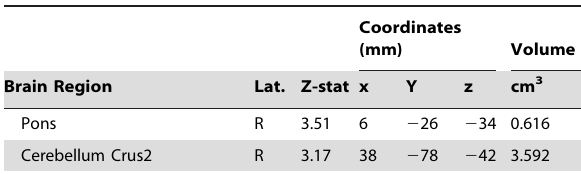
Brain Region Lat. Z-stat